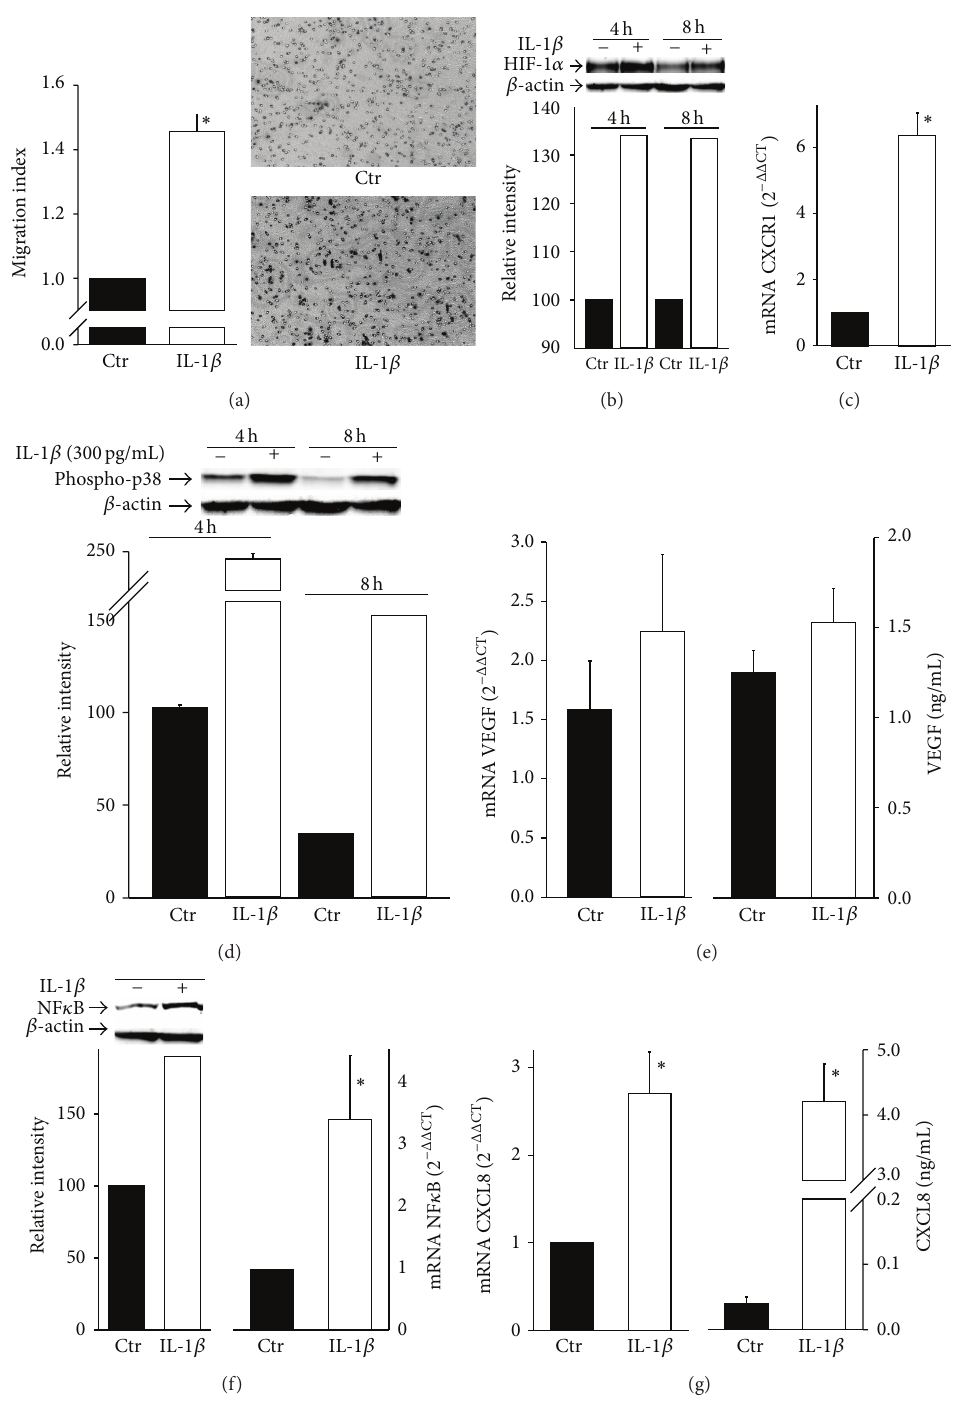
Figure1:IL-1 𝛽 increasesMDAMB231cellmigratoryabilityunderhypoxia.Dataareshownasmeans ± SEM. ∗ 𝑃 < 0.05 ,statisticallysignificant difference between IL-1 𝛽 -treated hypoxic cells (IL-1 𝛽 ) and hypoxic control cells (Ctr). (a) The migration assay was performed as described in Section 2. The migration index was calculated as a fold change of relative CyQuant fluorescence of cells migrating into the lower chamber normalized to that of the untreated samples (Ctr) ( 𝑛 = 4 ). Migrating cells were photographed and photomicrographs of representative fields from the indicated conditions were shown. (b) Protein expression of HIF-1 𝛼 was determined by Western blot analysis at indicated time points. 𝛽 -actin was used as loading control. A representative blot from three independent experiments is shown. Quantification of HIF-1 𝛼 protein expression was achieved by chemiluminescence. (c) CXCR1 mRNA expression was determined by qRT-PCR analysis ( 𝑛 = 3 ). (d) Protein expression of phospho-p38 was determined by Western blot analysis. (e) VEGF-A mRNA and protein expression were analyzed by qRT-PCR and ELISA ( 𝑛 = 3 ). (f) Protein and mRNA expression of NF 𝜅 B was determined by Western blot and qRT-PCR analysis ( 𝑛 = 3 ). (g) CXCL8 mRNA and protein expression were analyzed by qRT-PCR and ELISA ( 𝑛 = 3